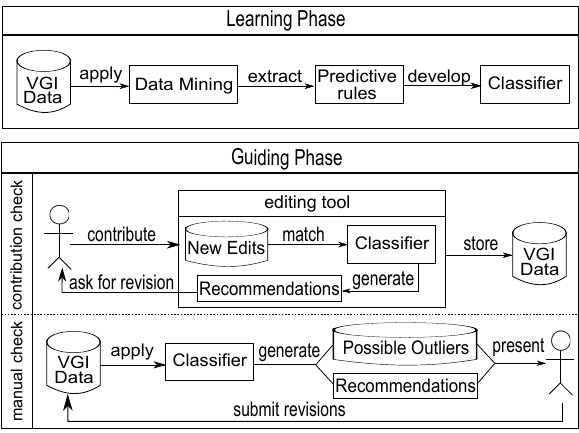
Figure 3: Guided classification approach